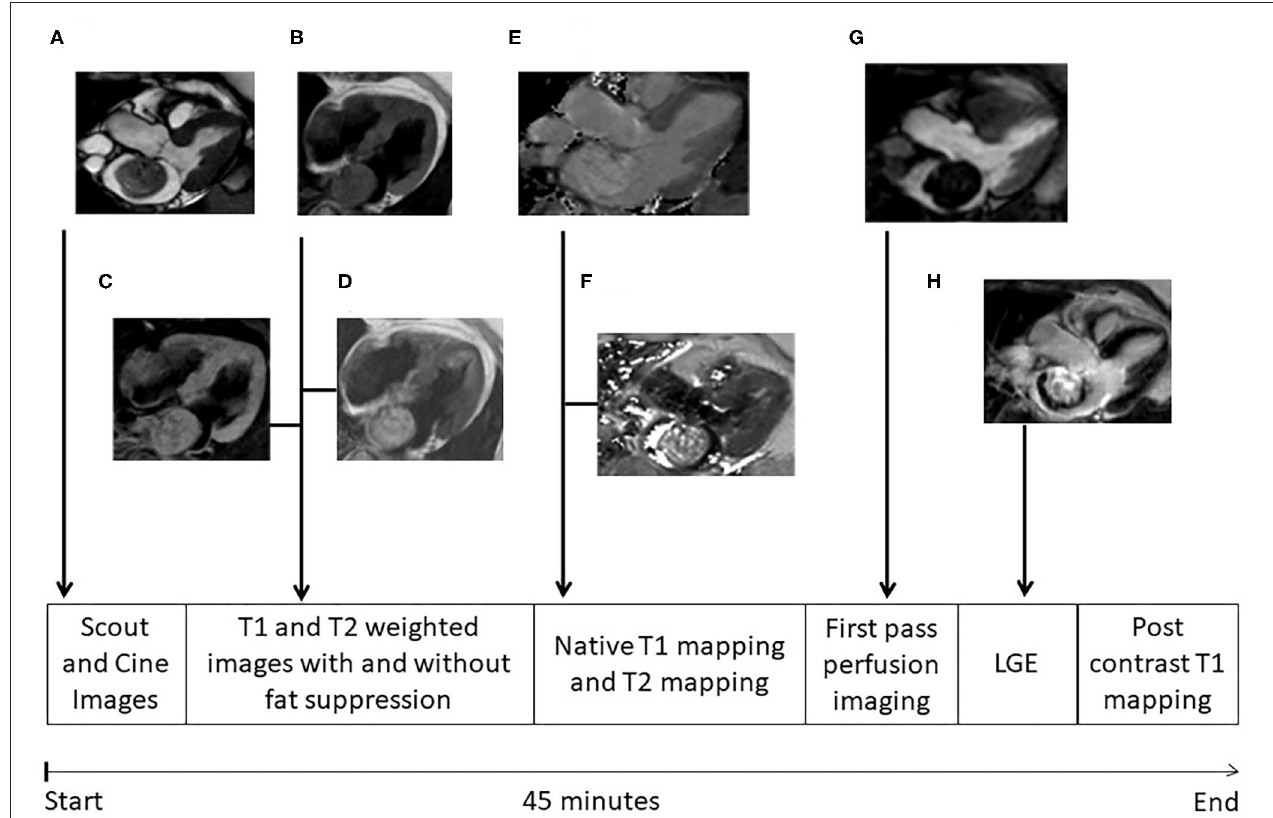
FIGURE 1 | MRI protocol. Different images of cardiac myxomas during cardiac magnetic resonance examination; (A) cine image in three chamber view; (B) T1 weighted image without fat suppression, myxoma having isointense signal; (C) T1 weighted image with fat suppression, myxoma also having isointense signal denoting no fat content in myxoma; (D) T2 weighted image without fat suppression, myxoma having hyperintense signal; (E) T2 mapping; (F) T1 mapping; (G) First pass perfusion; (H) Late gadolinium enhancement, myxomas showing heterogeneous pattern of delayed enhancement. The whole protocol takes ∼ 45min to